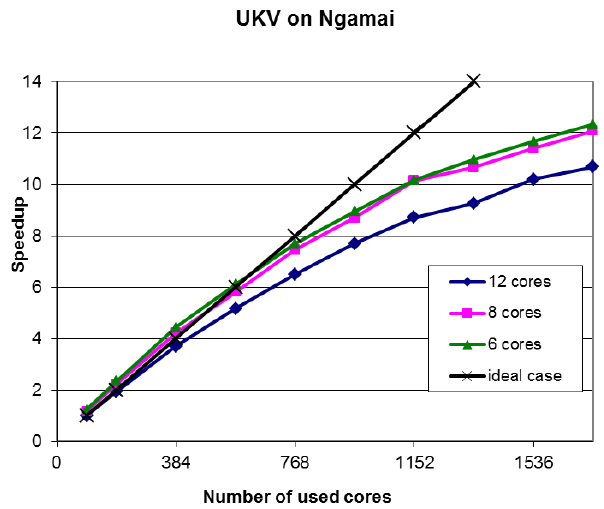
Figure 7. Speedup as a function of number of used cores on Nga- mai. Speedup was calculated in relation to the elapsed time of 9608s obtained for a 96-core run on fully committed nodes.